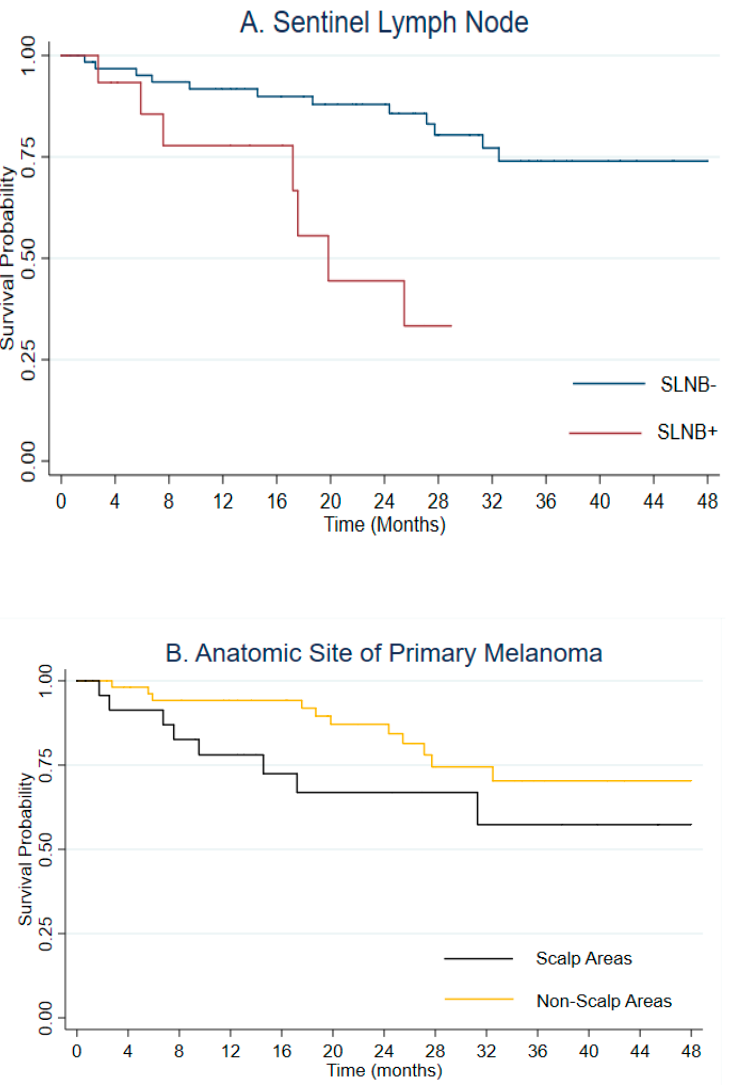
Figure 1. Progression free survival of H&N Melanoma stratified by sentinel lymph node status (panel ( A )) and anatomic site (panel ( B )). Table 2. Univariate Cox Regression Analysis on relapse ‐ free survival.